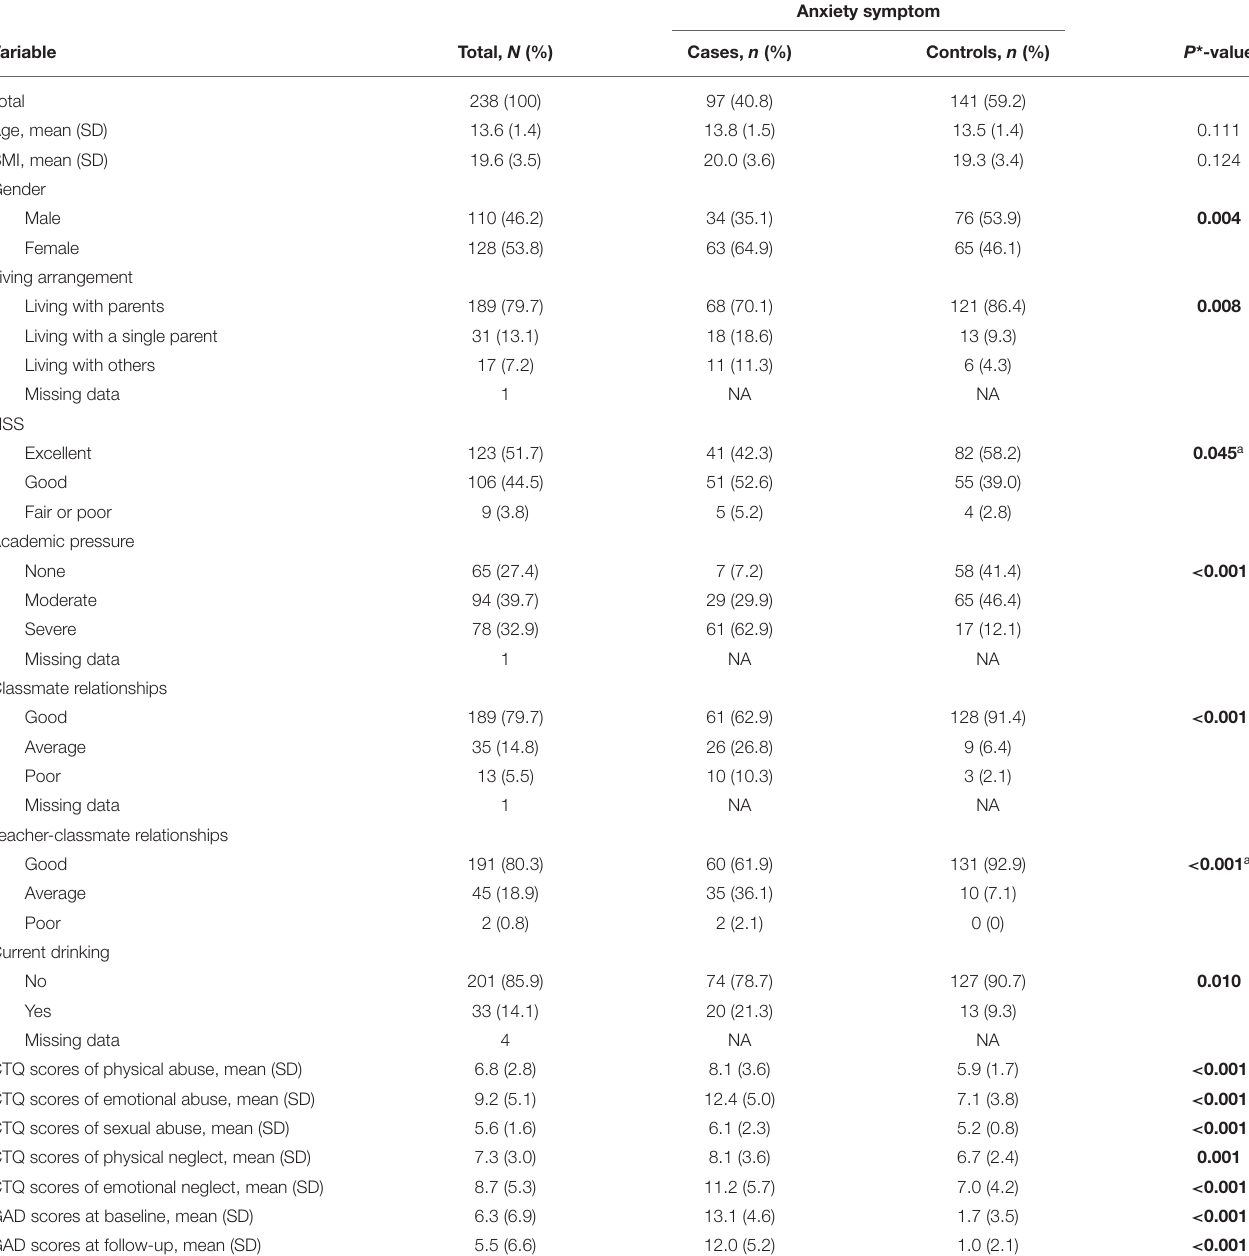
TABLE 1 | Baseline sample characteristics among 238